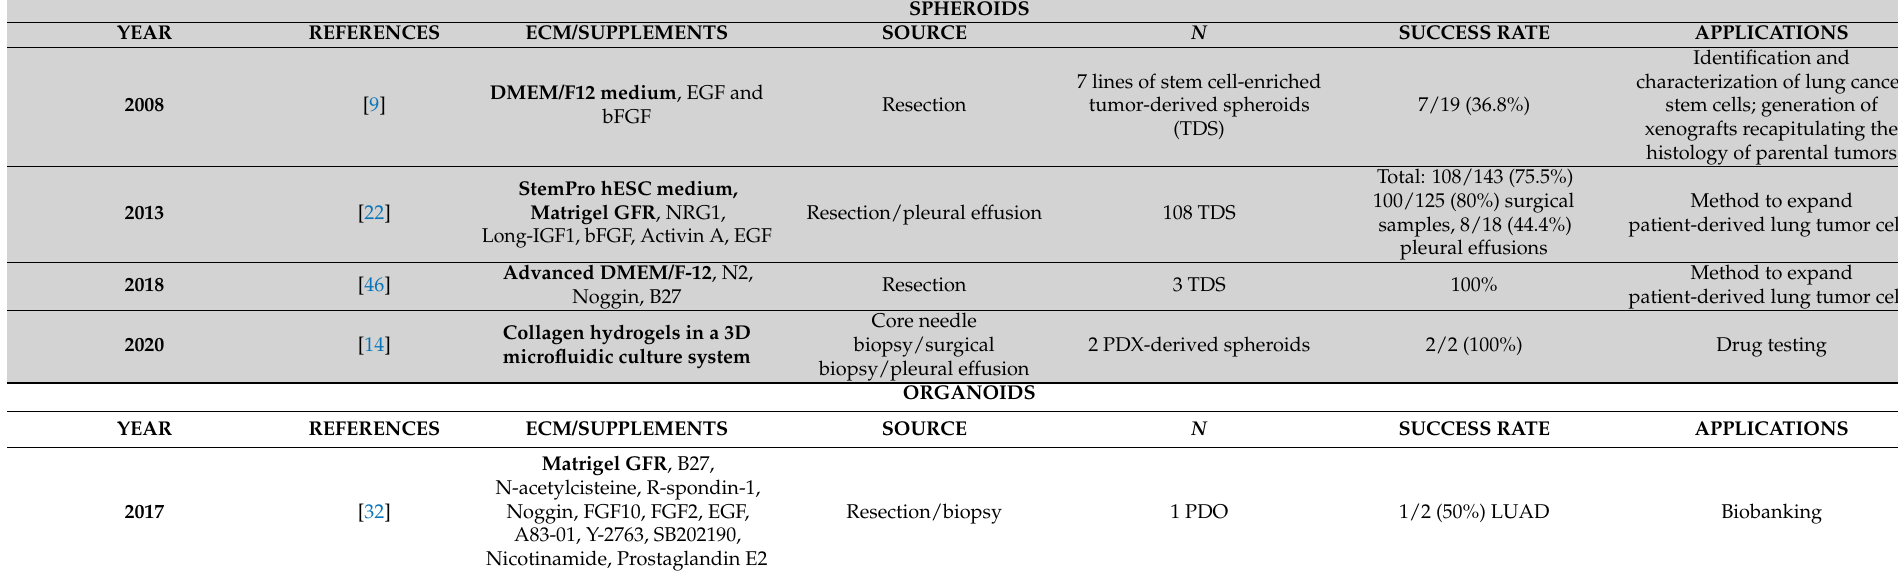
Table 1. Main studies in the field of lung cancer spheroids and organoids. ECM, extra-cellular matrix; MBM, minimum basal medium; EGF, Epidermal Growth Factor; bFGF, basic Fibroblast Growth Factor; FGF, Fibroblast Growth Factor; HGF, Hepatocyte Growth Factor; LUAD, lung adenocarcinoma; LUSC, lung squamous cell carcinoma; LCNEC, large-cell neuroendocrine carcinoma; SCLC, small-cell lung cancer; NSCLC, non-small-cell lung cancer; TDS, tumor-derived spheroids; PDX, patient-derived xenograft; PDOs, patient-derived organoids; LCOs, lung cancer organoids; hESCs, human embryonic stem cells; GFR, growth factor reduced; NRG1, Neuregulin-1; IGF1, Insulin-like Growth Factor-1; DMEM/F12, Dulbecco’s Modified Eagle’s Medium and Ham’s F-12 Nutrient Mixture; N2, N2 supplement; B27, B27 supplement; XDOs, xenograft-derived organoids; ALI, air–liquid interface; SAG, smoothened agonist; PBLs, peripheral blood lymphocytes. Others: adenoid cystic carcinoma, sarcomatoid carcinoma, atypical carcinoid, mucoepidermoid carcinoma, LCNEC; NA, not